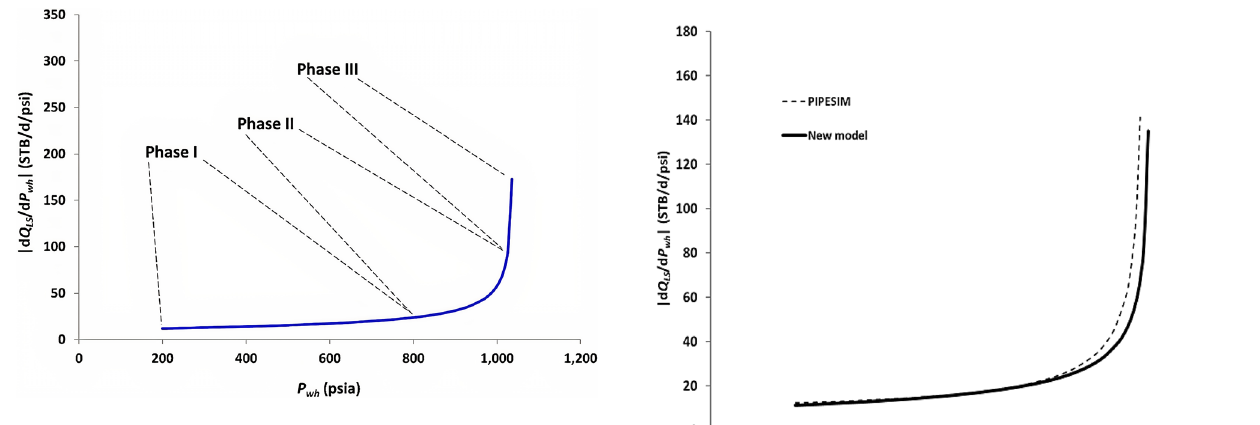
Fig. 7 Stability plot for well A based on the new model and new pro- cedure